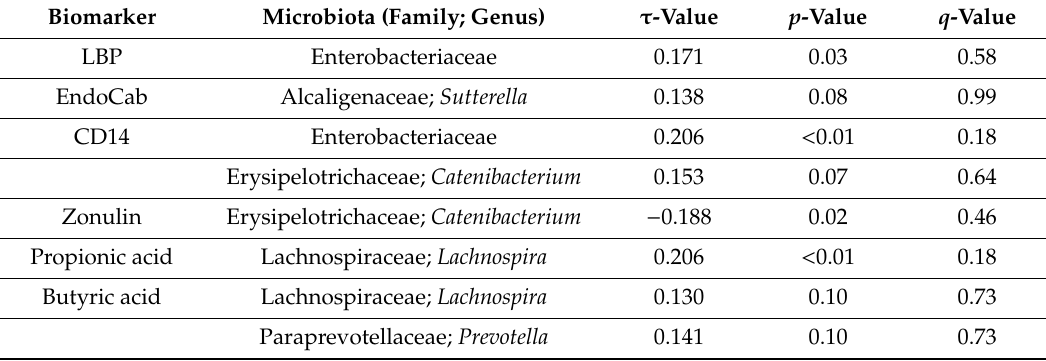
Table 4. Associations of translocation markers and short chain fatty acids with microbiota.